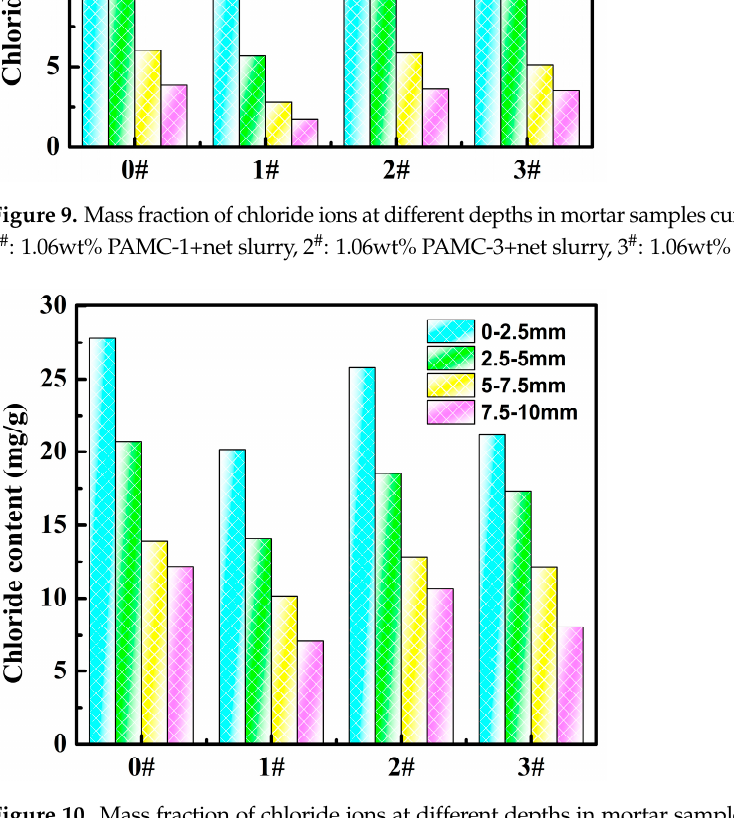
Figure 10. Mass fraction of chloride ions at different depths in mortar samples cured for 28 d (0 # : net slurry, 1 # : 1.06wt% PAMC-1+net slurry, 2 # : 1.06wt% PAMC-3+net slurry, 3 # : 1.06wt% PAMC-6+net slurry).